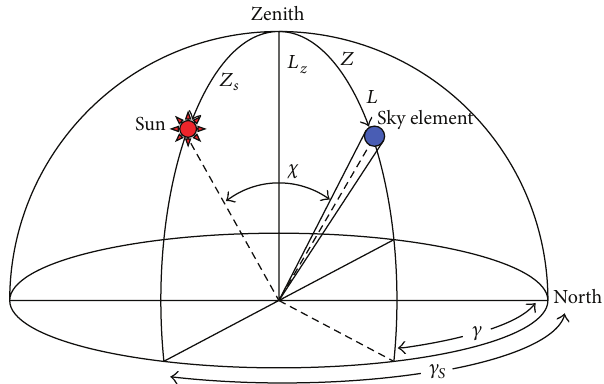
Figure 3: Diagram of the sky showing luminance ( L ) from a sky element, zenith angle of the sun (𝑍 𝑠 ) , zenith angle of the sky element ( Z ),indicatrixangle( 𝜒 ),azimuthoftheskyelement (𝛾) ,andazimuth of the sun (𝛾 𝑆 ) .